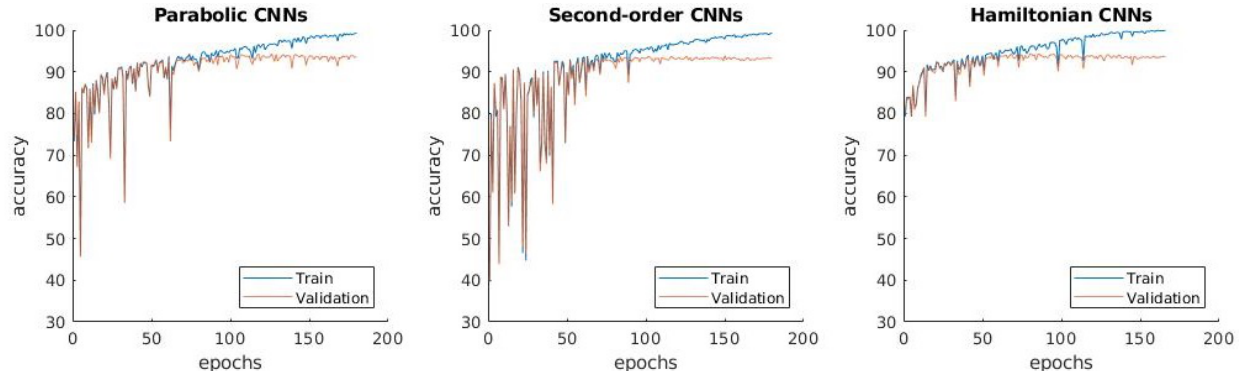
Figure 3. Exp 1 : Accuracy on normal vs. pneumonia classes (train: 12,150, validation: 3039